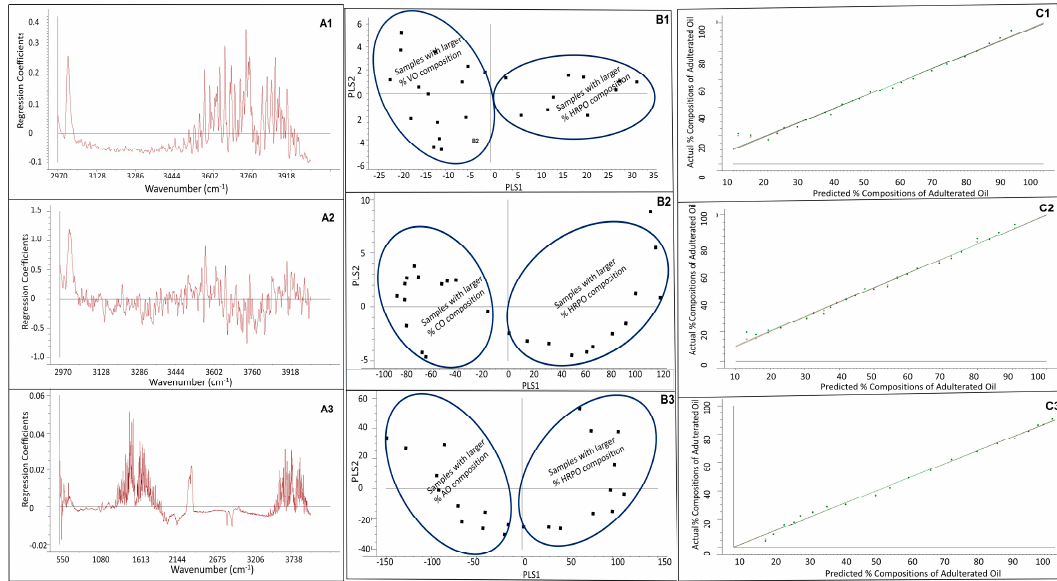
Figure 3. Summary of the partial least square (PLS) regression: ( A1 ) regression coefficient of PLS versus wavenumber of HRPO adulterated with vegetable oil; ( A2 ) regression coefficient of PLS versus wavenumber of HRPO adulterated with canola oil; ( A3 ) regression coefficient of PLS versus wavenumber of HRPO adulterated with almond oil; ( B1 ) score plot of PLS regression of HRPO adulterated with vegetable oil; ( B2 ) score plot of PLS regression of HRPO adulterated with canola oil; ( B3 ) score plot of PLS regression of HRPO adulterated with almond oil; ( C1 ) plot of predicted versus actual composition of HRPO adulterated with vegetable oil; ( C2 ) plot of predicted versus actual composition of HRPO adulterated with canola oil; ( C3 ) plot of predicted versus actual composition of HRPO adulterated with almond oil.